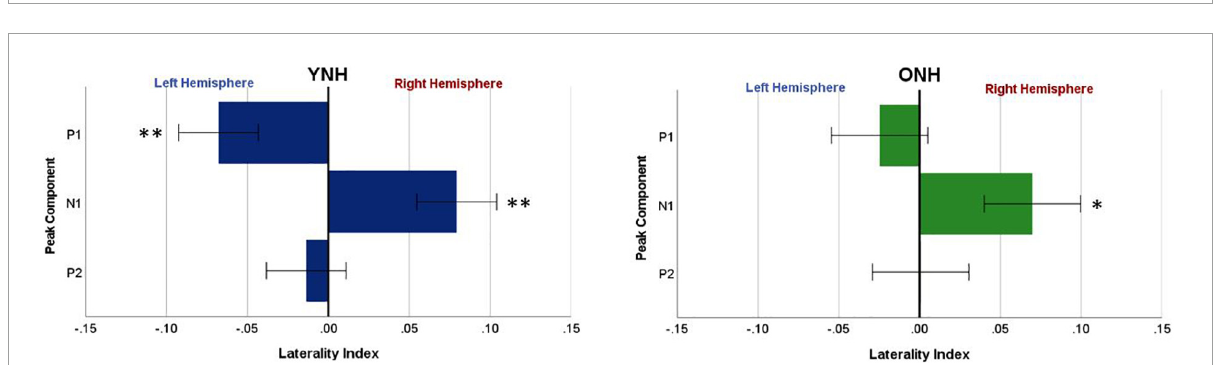
FIGURE9 Mean laterality index, averaged across interaural time difference (ITD), plotted relative to latency of peak components (P1, N1, P2) for YNH (left panel) and ONH (right panel) groups. Significant laterality (relative to zero) for given components for each group separately is indicated for the following p -values: ∗ p < 0.05, ∗∗ p < 0.01